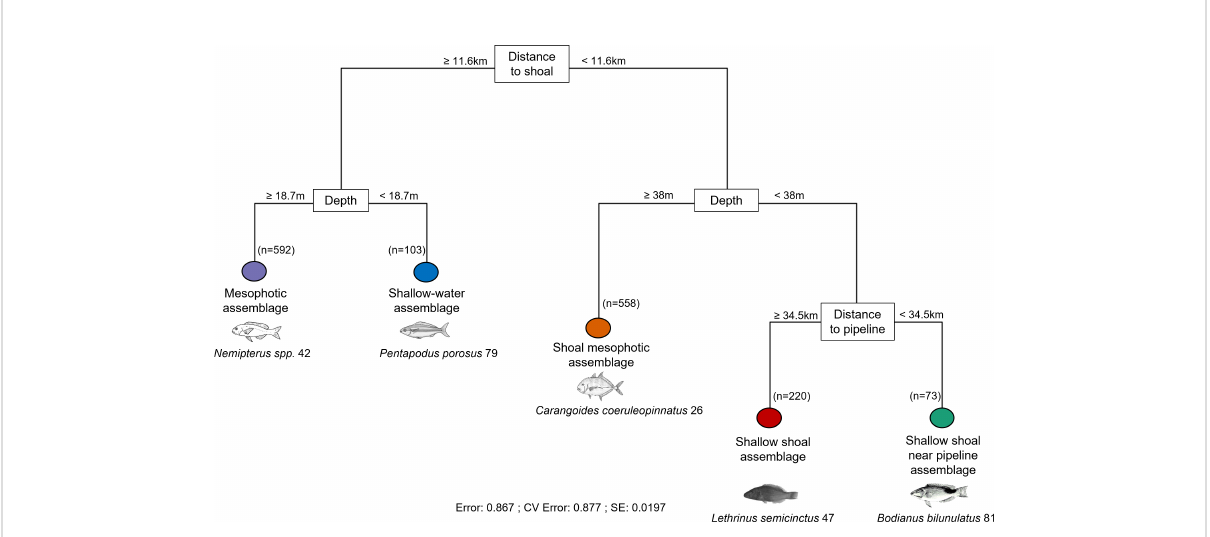
FIGURE 4 Pruned (1 SE) multivariate regression tree (MRT) de fi ning assemblage composition of demersal fi shes (n=1546 BRUV deployments) on the NW Shelf constrained by environmental predictors. The terminal nodes identi fi ed fi ve distinct assemblages (see Table 2) with breaks labelled with the environmental predictor that best split the data into the most homogenous groups possible and the value of each predictor that best distinguished them. The number of BRUV deployments within each terminal node is also indicated (n). Top indicator taxa with highest values of Dufrene-Legendre index (DLI) are shown for each terminal